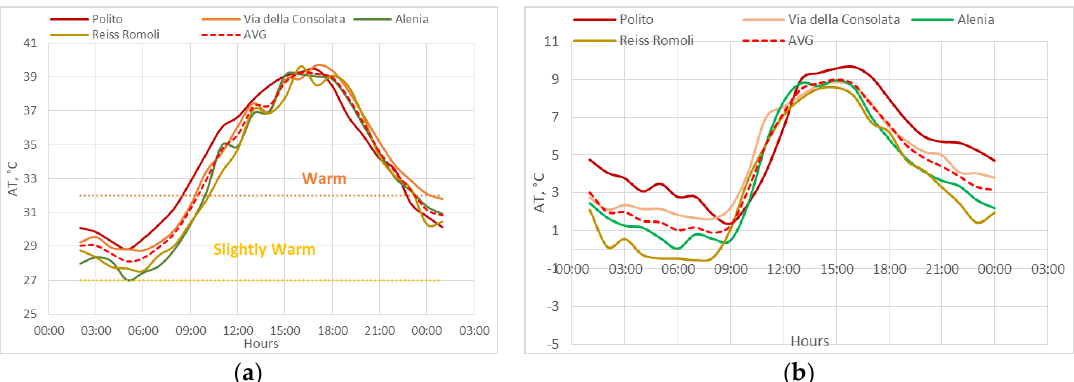
Figure 22. Apparent Temperature (AT): ( a ) 25 August 2016 ( b ) 21 January 2016.